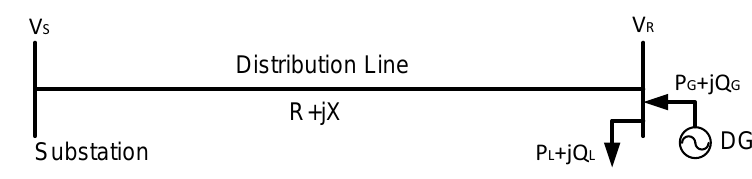
Figure 1. System used to illustrate the issue of voltage rise.